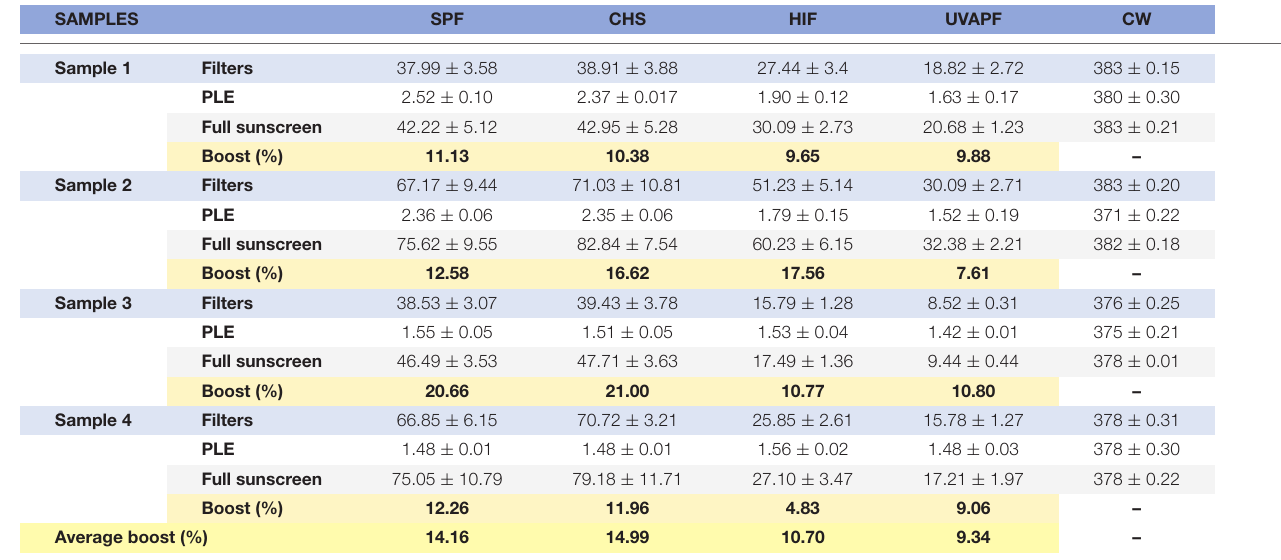
TABLE 2 | Solar protection factors, UVA protections factors, the relation between UVA/UVB, the critical wavelength (CW), the contact hypersensitivity factor (CHS), and the human immunoprotection factor (HIF) for different combinations of filters with PLE (full sunscreen) compared with the formula containing only filters and the formula containing only